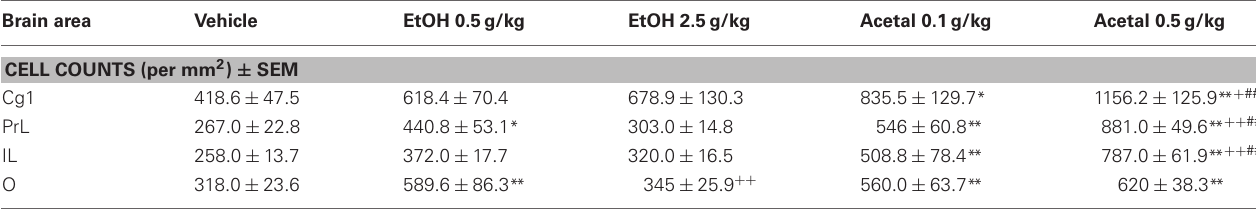
Table 1 | Effect of acute IP administration of EtOH or acetaldehyde on c-Fos expression in PFC areas of rat brain. Brain area